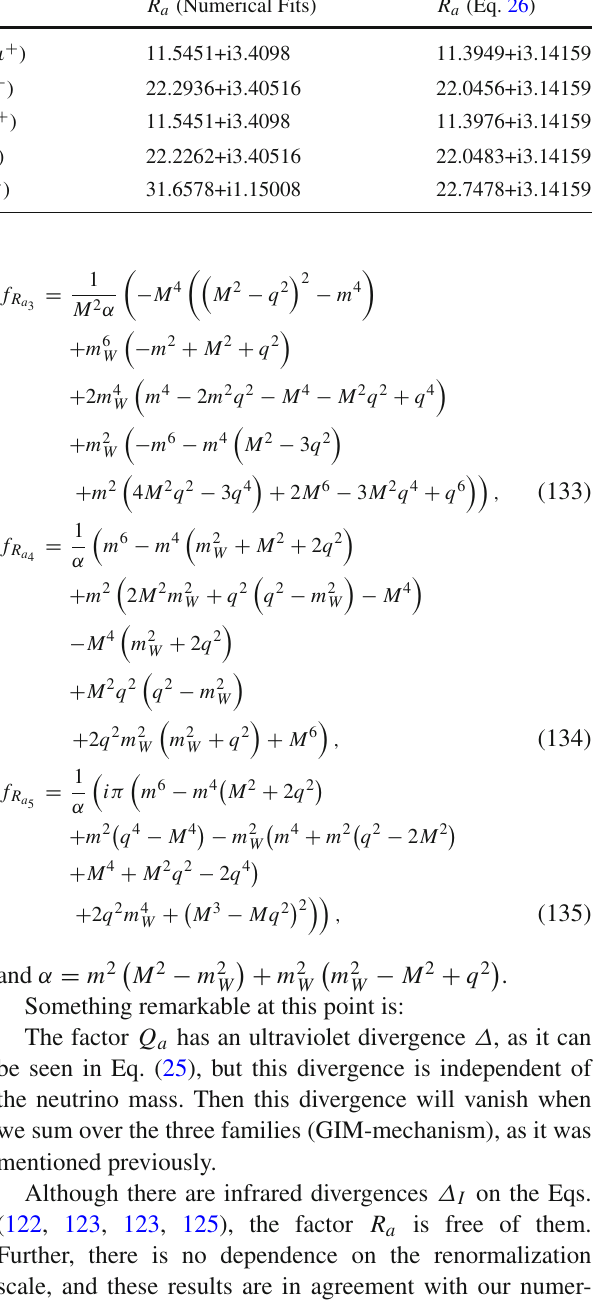
Table 9 Comparison for the R a factor using numerical fits vs Eq. (26)